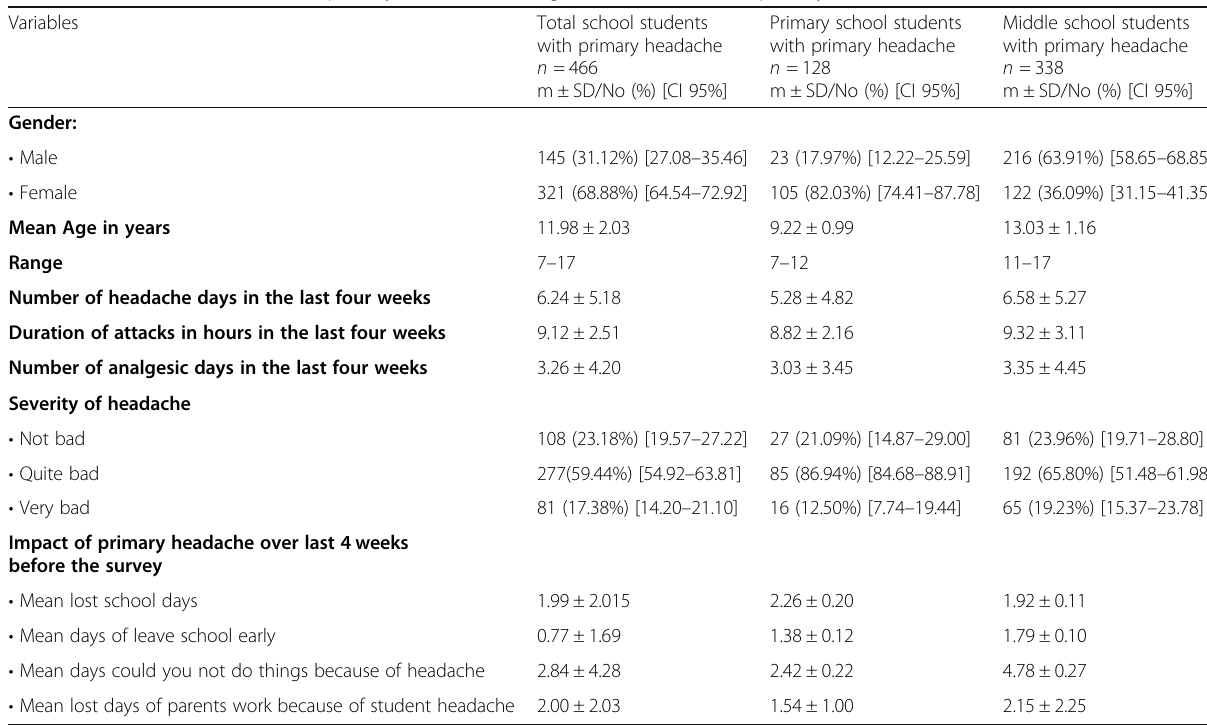
Table 1 Characters and burden of primary headache among school children with primary headache disorders (No = 466)